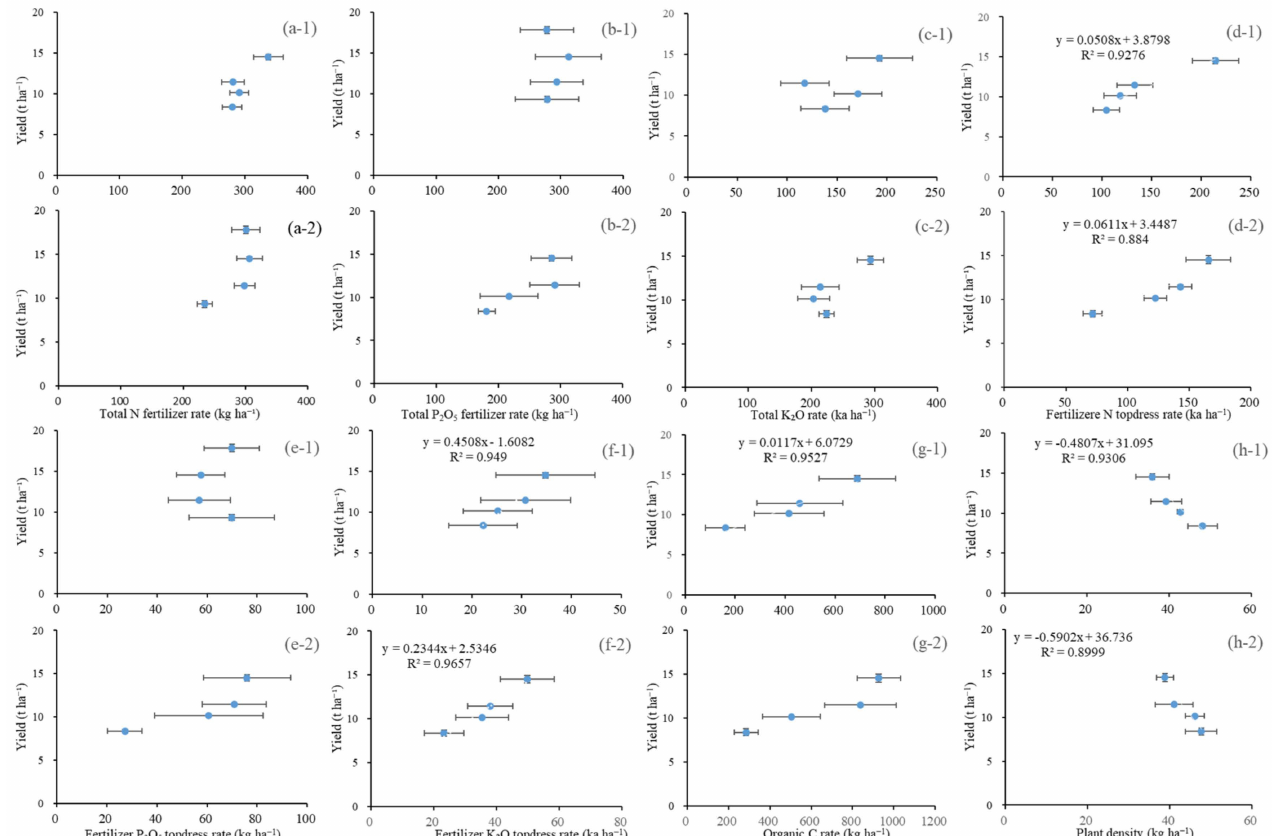
Figure 4. Relationships between yield and total N fertilizer rate, total P 2 O 5 fertilizer rate, total K 2 O fertilizer rate, N fertilizer top-dress, P 2 O 5 fertilizer top-dress rate, K 2 O fertilizer top-dress rate,